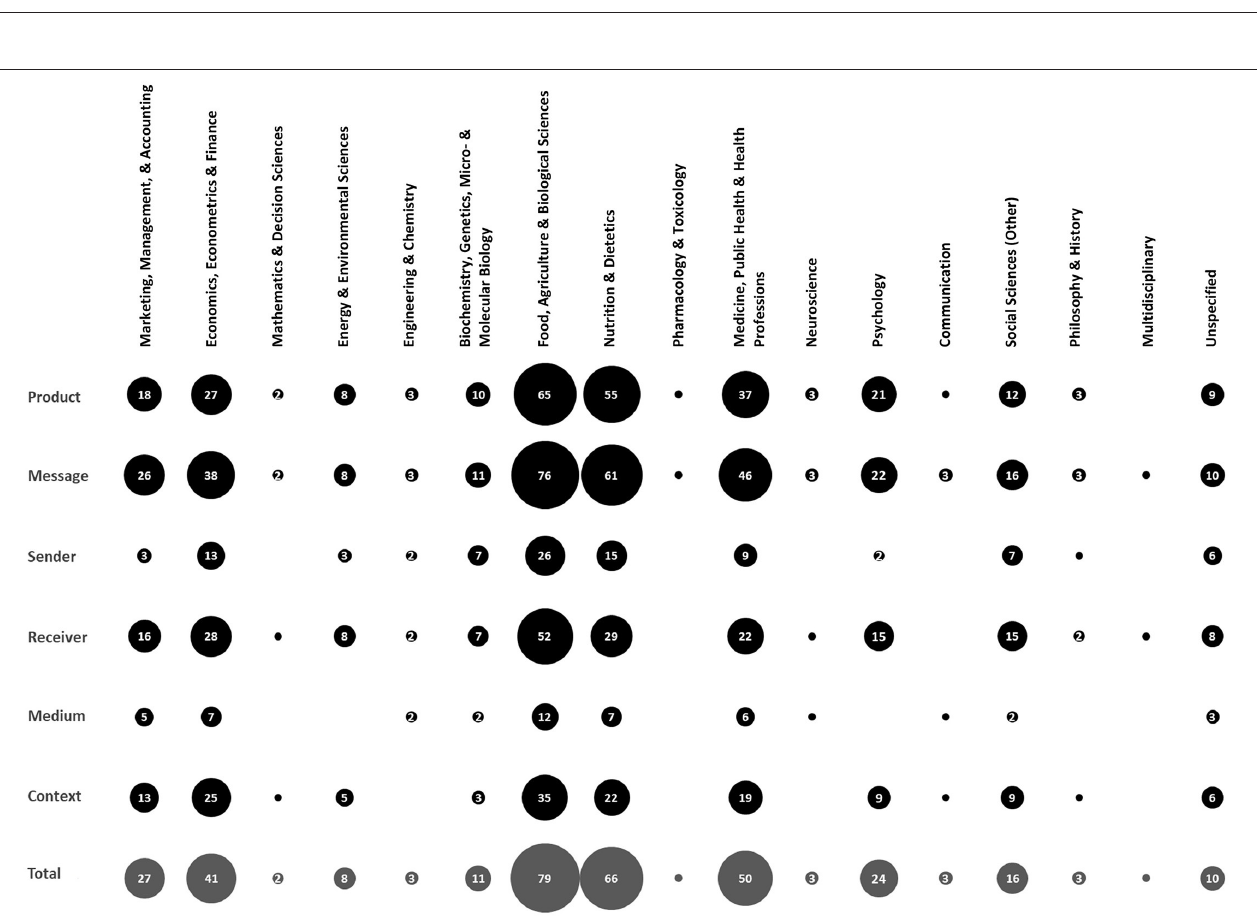
FIGURE 5 | Prevalence of empirical studies in each discipline related to each element (i.e., product, message, sender, receiver, medium, and context) and in total. Numbers in bubbles specify the prevalence. Note that bubbles with no number represent only one record.